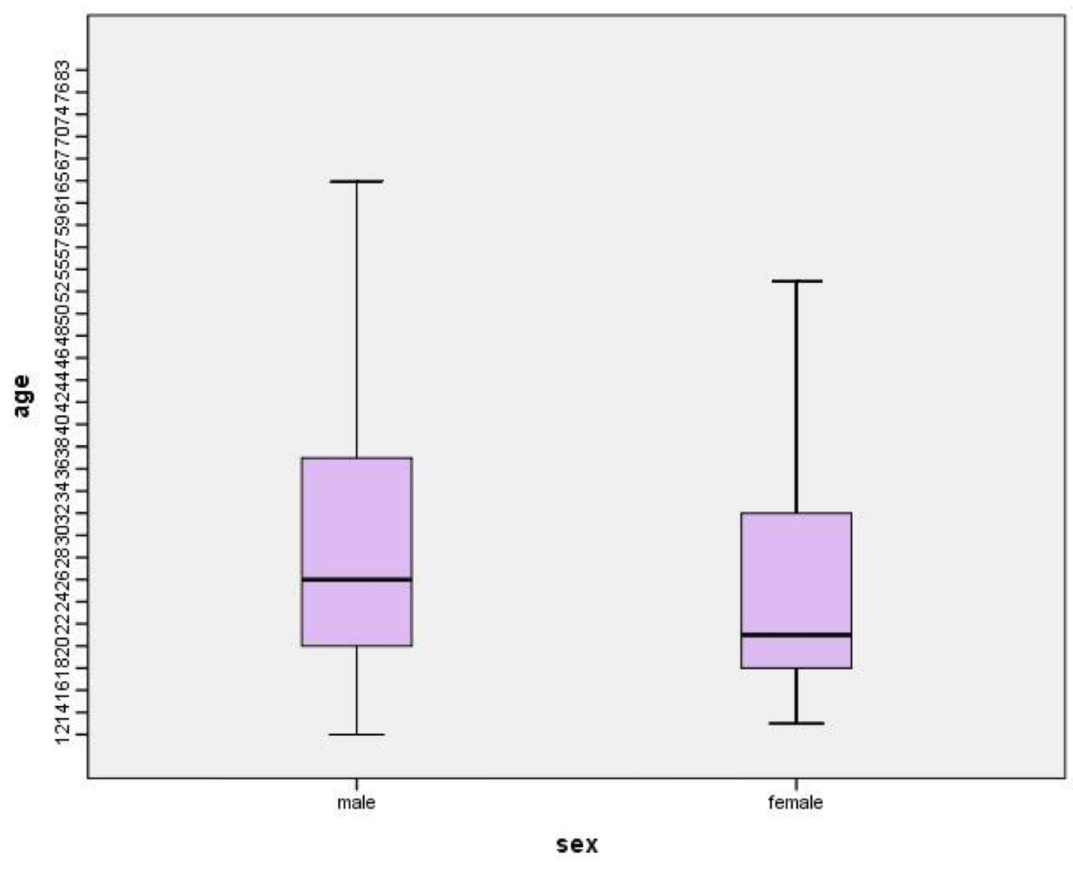
Figure 1. Age of subjects studied by gender.